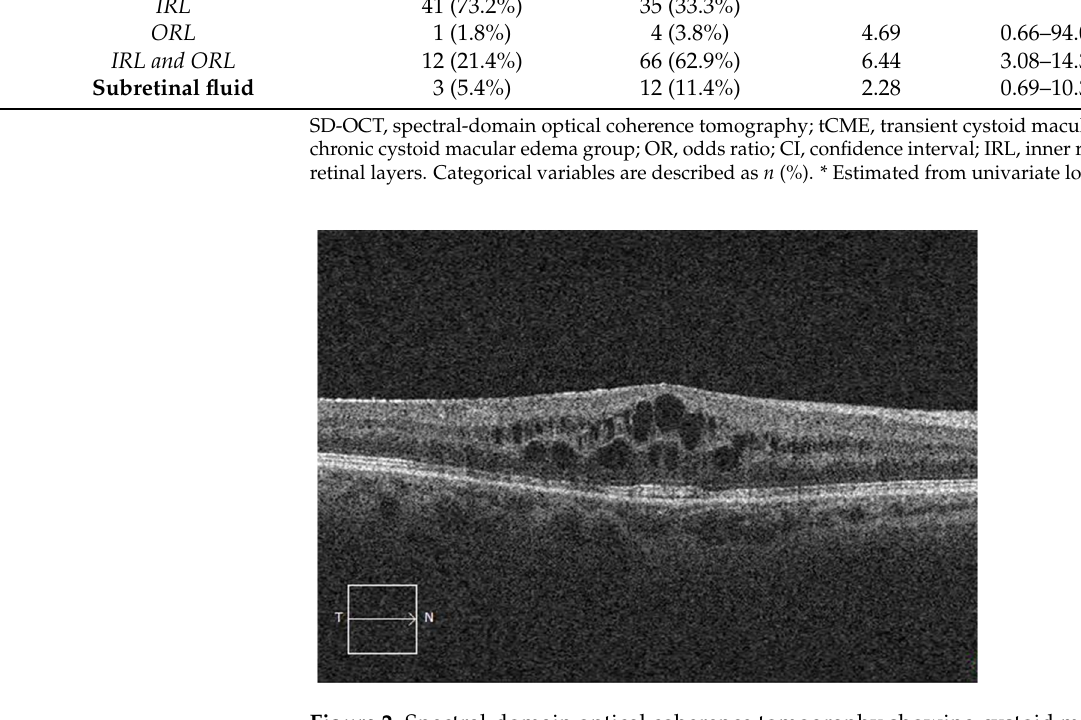
Figure 2. Spectral-domain optical coherence tomography showing cystoid macular edema in both inner and outer retinal layers after vitrectomy for rhegmatogenous retinal